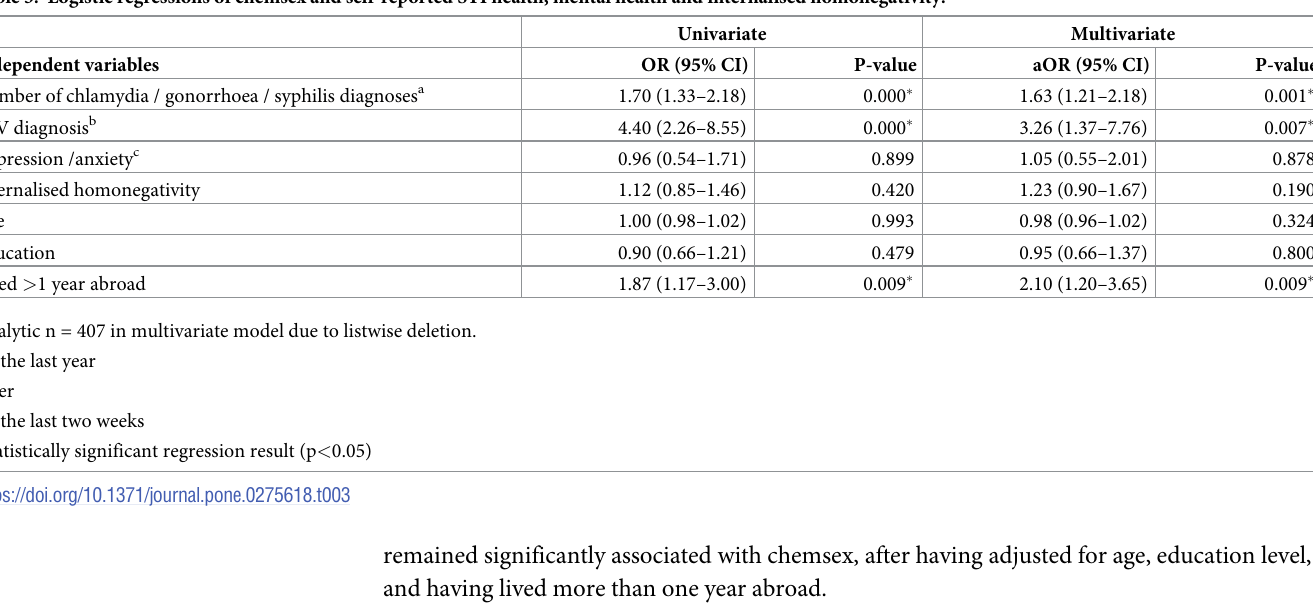
Table 3. Logistic regressions of chemsex and self-reported STI health, mental health and internalised